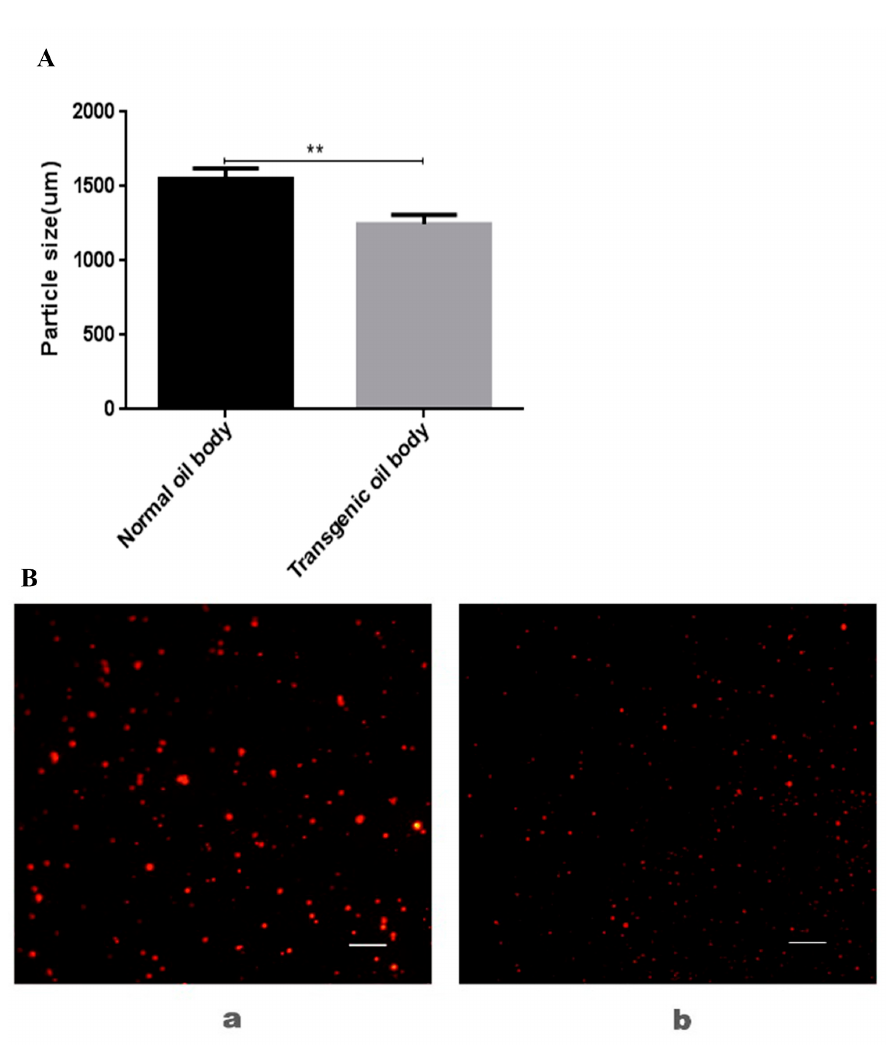
Figure 3. Measurement and observation of size and microstructure from transgenic oil body and normal oil body. ( A ) Particle size; ( B ) microstructure observation; (a) dyed normal oil bodies via Nile red; (b) dyed transgenic oil bodies via Nile red. The images were shown at 40 × 10 magnification (scale bars = 10 µ m). ** p < 0.01 vs. normal group.